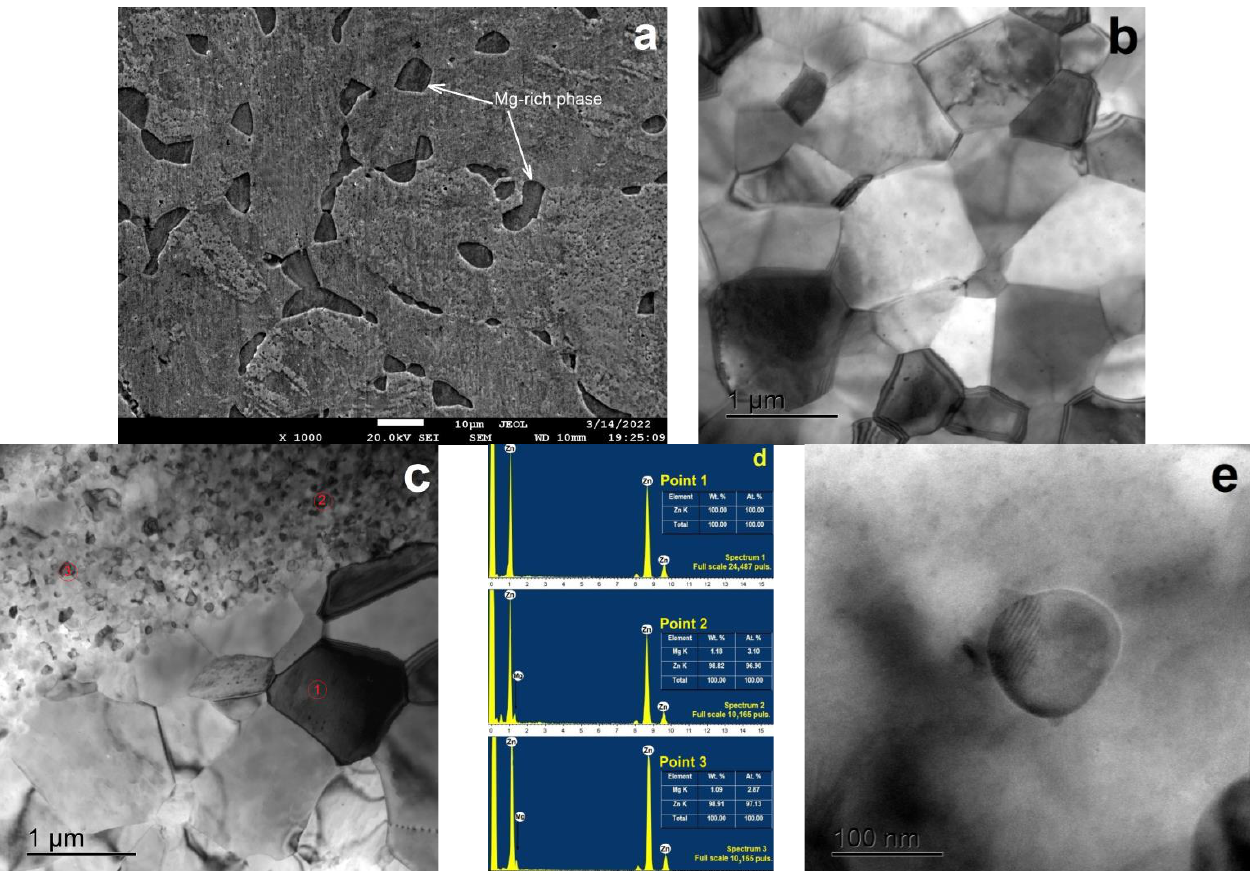
Figure 2. SEM-image (SE-contrast) structure of the Zn–1%Mg alloy in the annealed state ( a ) and the TEM-images (bright field) of the structure of the Zn–1%Mg alloy after HPT ( b , c ); TEM-EDS point analysis result of the Zn–Ca particle ( d ) and HRTEM-image of intermetallic particles based on Zn–Mg ( e